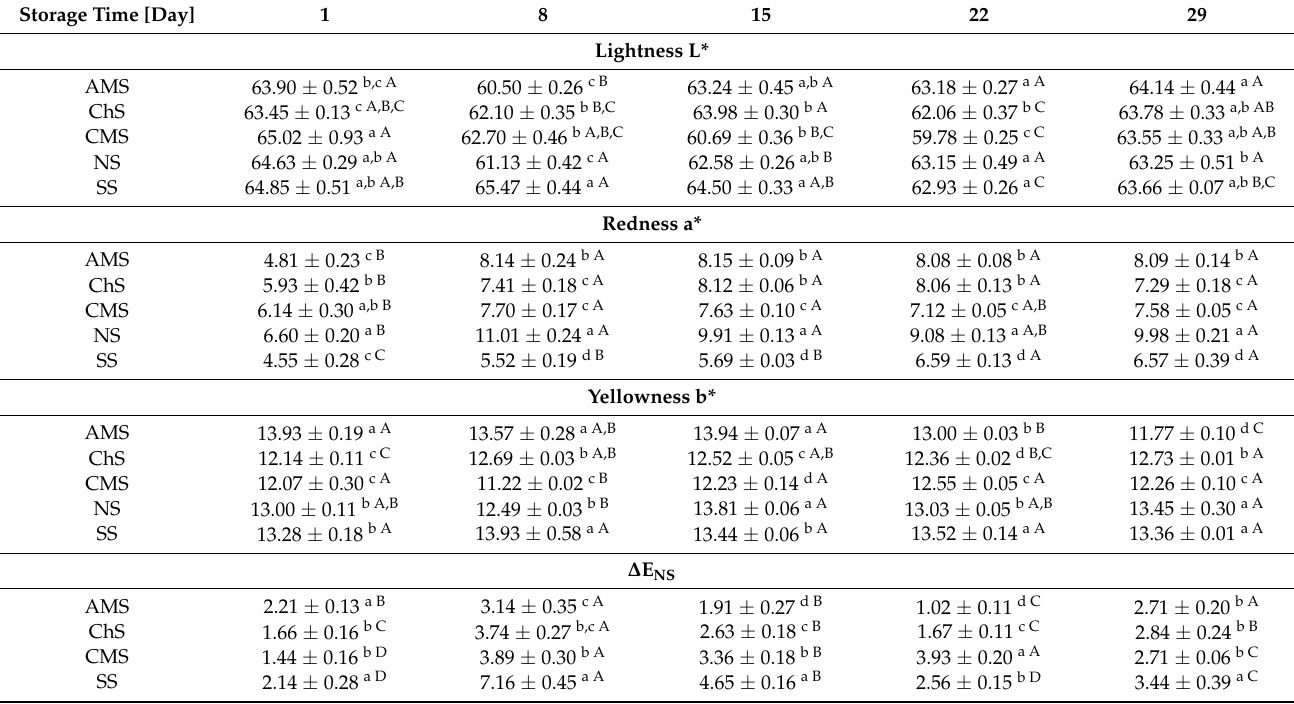
Table 2. Effect of Aronia melanocarpa, Chaenomeles superba, and Cornus mas leaf extracts on color parameters (Lightness L*, redness a*, yellowness b*) of pork sausages stored in MAP at 4 ◦ C (mean ±